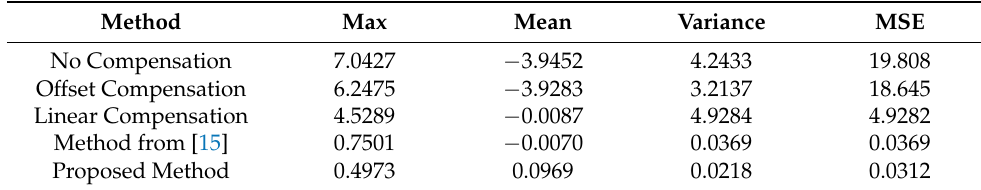
Table 11. Experimental results, with substantially unaligned axes and inclined